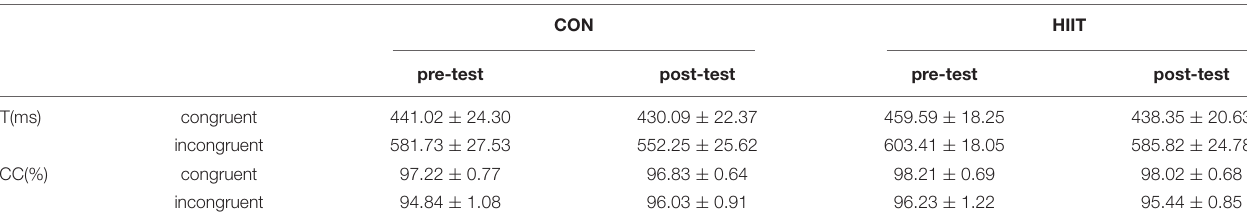
TABLE 2 | Accuracy and response time in stroop task of HIIT group and Control group (X ± SE). CON